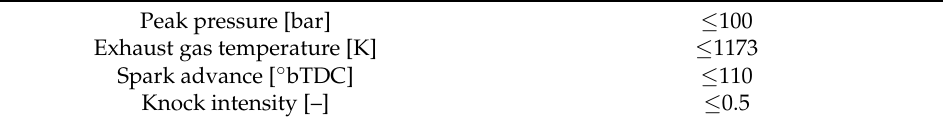
Table 5. Engine operating limits.